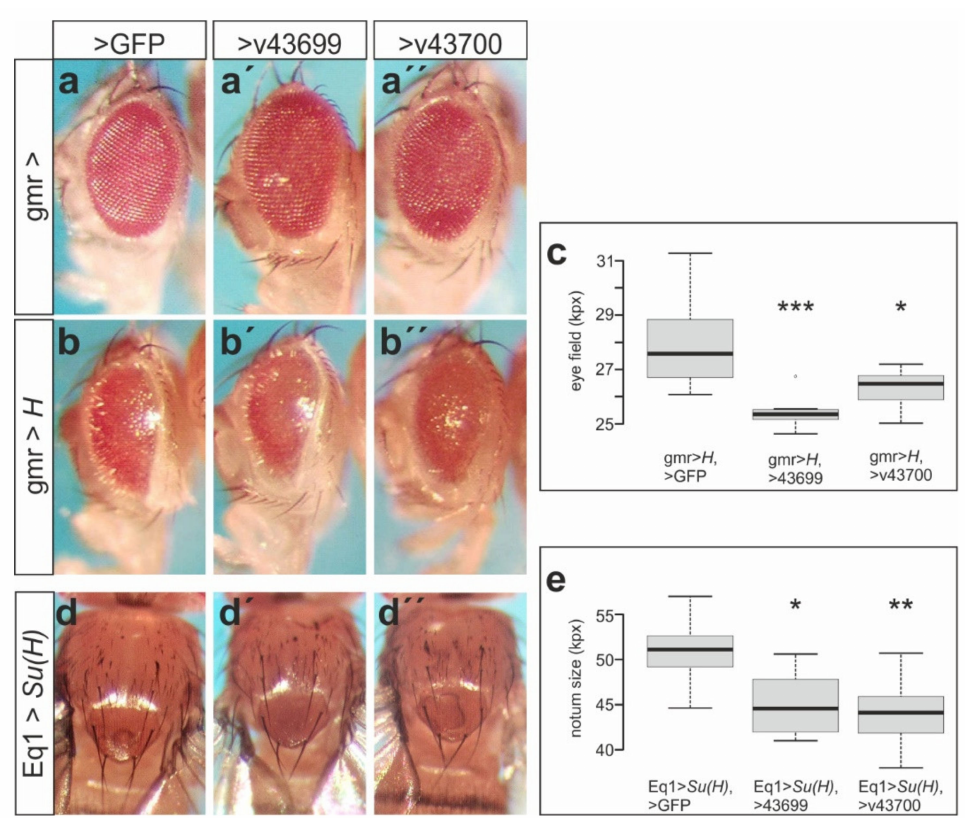
Figure 6. Mnr regulates Notch activity. Knockdown of mnr activity by RNA interference influences Notch signaling output. Female flies are shown. ( a – a” ) Overexpressed in the developing eye, two independent RNAi lines (v43699, v43700) have little impact on eye development. ( b – b” ) Both lines significantly improve the small eye phenotype resulting from H overexpression. ( c ) Statistical evaluation of eye size from females of the given genotype ( n = 8). Boxplots with center lines indicating the medians and box limits the 25th and 75th percentiles (R-software); whiskers extend 1.5 time the interquartile range; outliers are represented by dots. ( d – d” ) Size increase following Su(H) overexpression in the center of the presumptive thorax ( d ) is reduced by concurrent downregulation of mnr ( d’ , d” ). ( e ) Statistical evaluation of thorax size from females of the given genotype. The area between the dorso-central bristles up to the prothorax was measured. Boxplots are as in ( c ); n = 8. ( c , e ) Significance was tested by ANOVA two-tailed Dunnett’s approach for multiple comparisons relative to UAS-GFP-control (*** p < 0.001, ** p < 0.01, * p < 0.05). Genotypes: gmr-Gal4/+; UAS- GFP/+ ( a ), gmr-Gal4/+; UAS-v43699/+ ( a’ ), gmr-Gal4/+; UAS-v43700/+ ( a” ), gmr-Gal4 UAS- H /+; UAS-GFP/+ ( b ), gmr-Gal4 UAS- H /+; UAS-v43699/+ ( b’ ), gmr-Gal4 UAS- H /+; UAS-v43700/+ ( b” ), Eq1-Gal4 UAS- Su(H) /+; UAS-GFP/+ ( d ), Eq1-Gal4 UAS- Su(H) /+; UAS-v43699/+ ( d’ ), Eq1-Gal4 UAS- Su(H) /+; UAS-v43700/+ ( d”